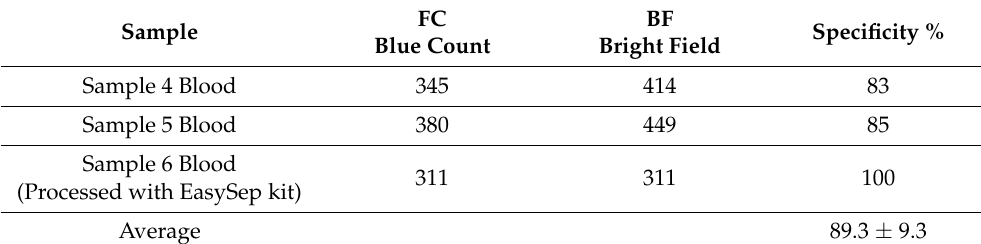
Table 2. Fluorescent Cell Imager (ZOE, Bio-Rad Laboratories, Hercules, CA, USA) used for specificity measurement. Cells/image. FC BF Specificity % Sample Blue Count Bright Field Sample 4 Blood 345 414 83